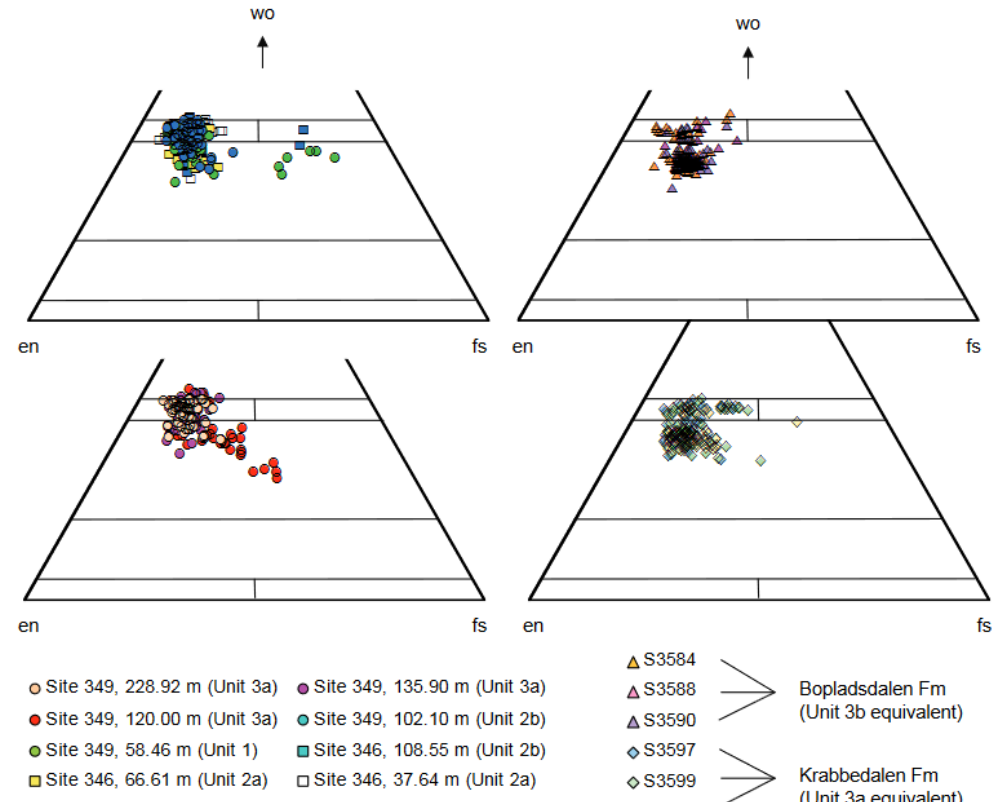
Figure 9. Clinopyroxenes from Deep Sea Drilling Project sites and Kap Brewster plotted on wo (wollastonite)—en (enstatite)—fs (ferrosalite) ternary diagrams [40].